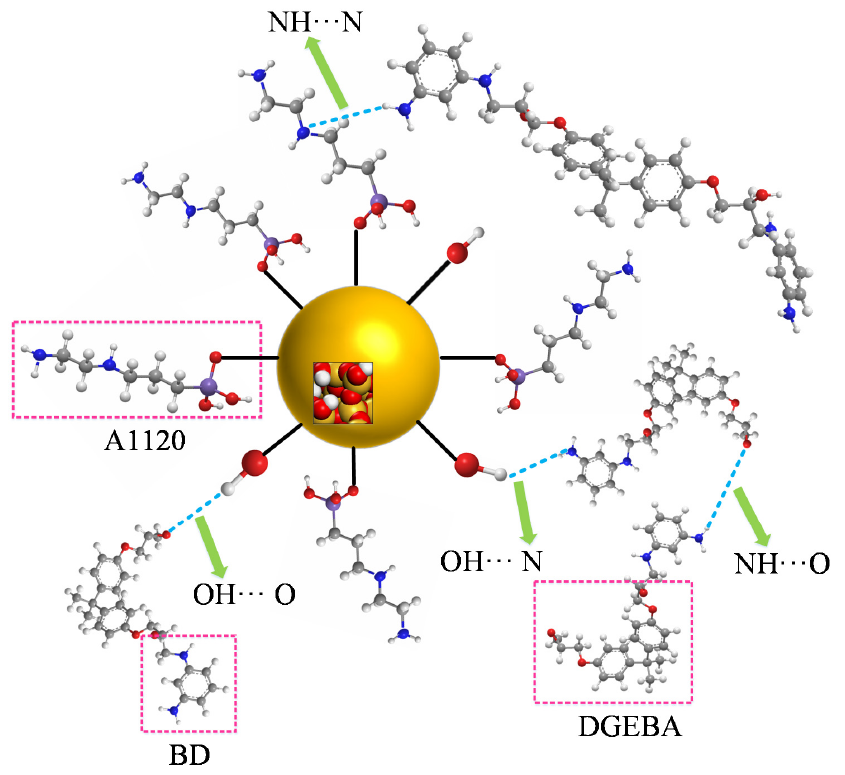
Figure 7. Schematic diagram of hydrogen bond.